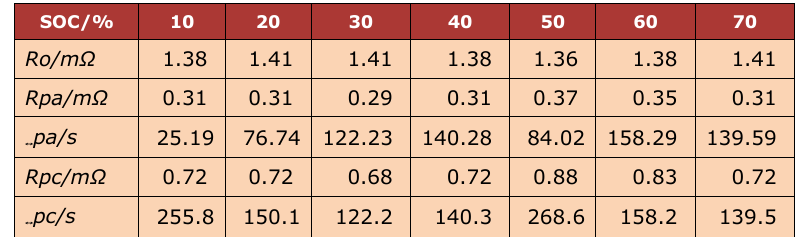
Table 2. Constant current test data based model parameters as a function of